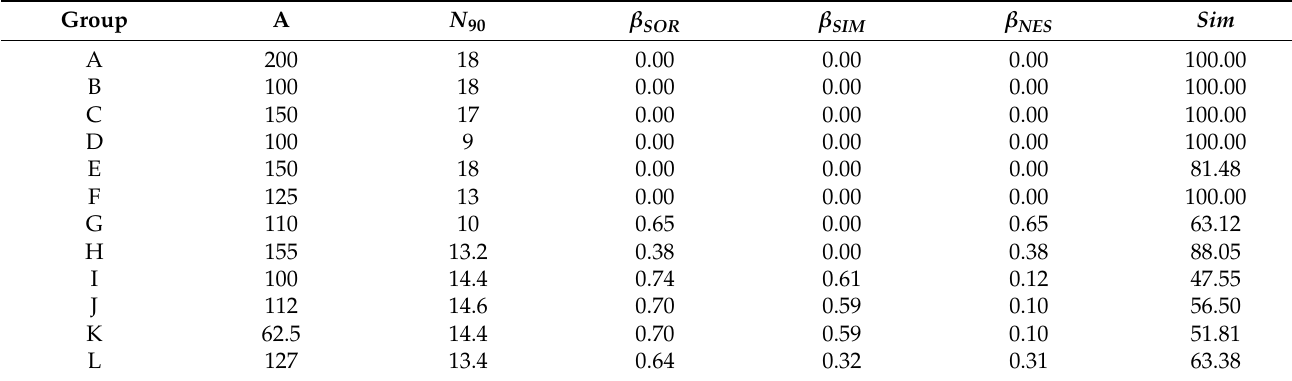
Table 2. Results of N 90 and values of β SOR , β SIM , β NES and within-group similarity ( Sim ) for the non-real data set. A is the mean abundance in the group of samples.